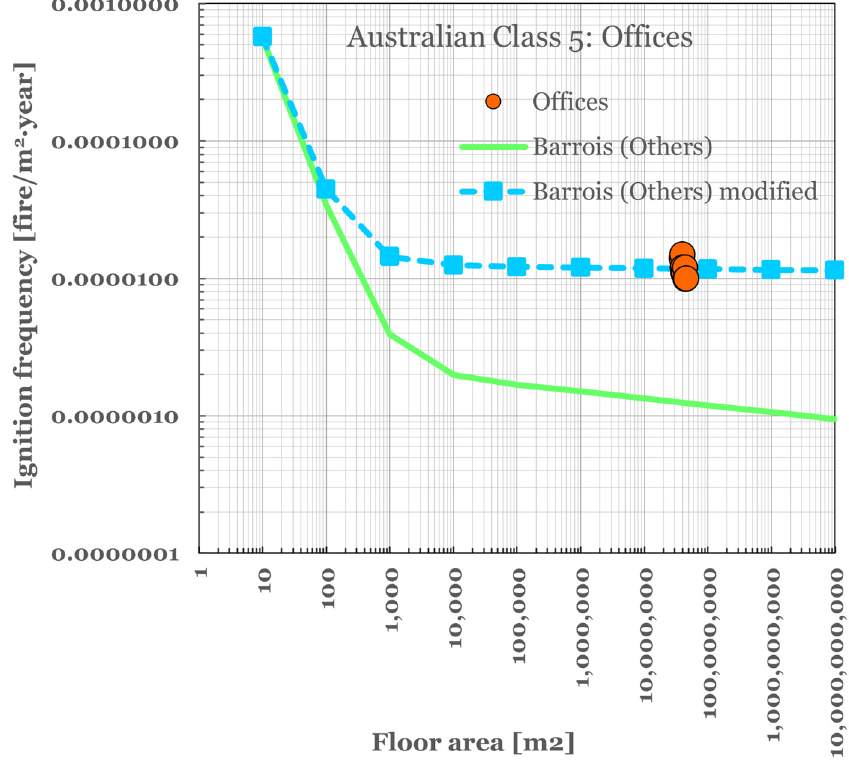
Figure 8. Ignition frequency curves for Australian Class 5—Offices derived from the Barrois model.